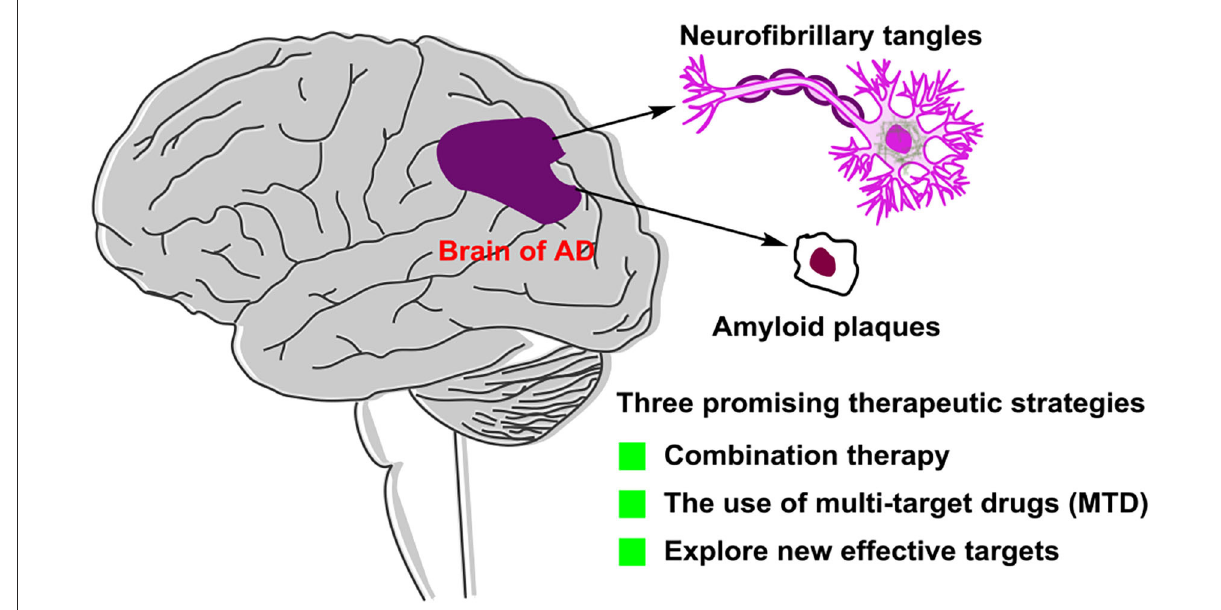
FIGURE11 Three promising therapeutic strategies for Alzheimer’s disease (AD) in